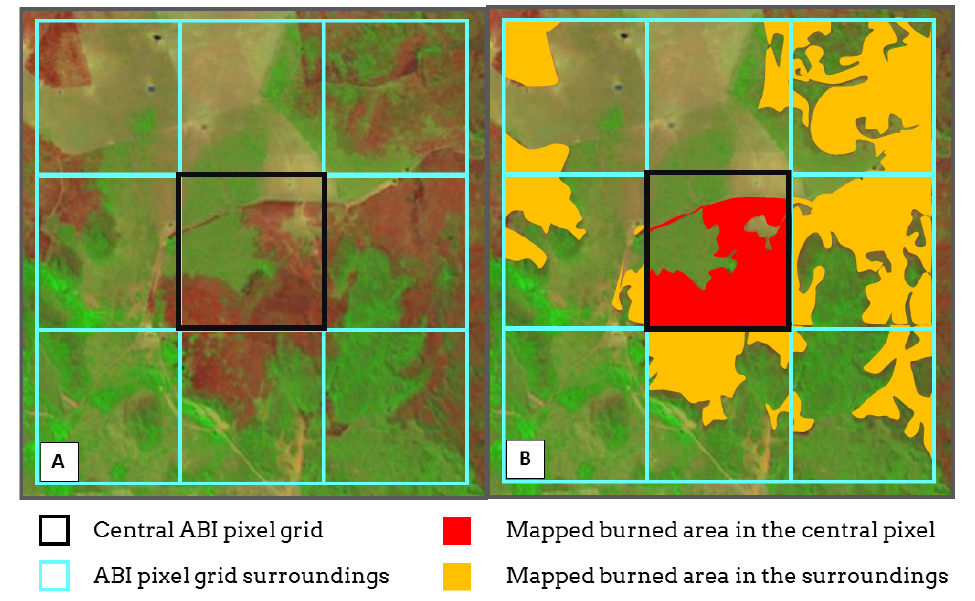
Figure 3. Example of burned area mapping in the central ABI pixel grid and surroundings based on Sentinel-2 imagery. RGB (B12, B8A, B04). ( A ) Remote sensing image without BA mapping. ( B ) Remote sensing image with BA